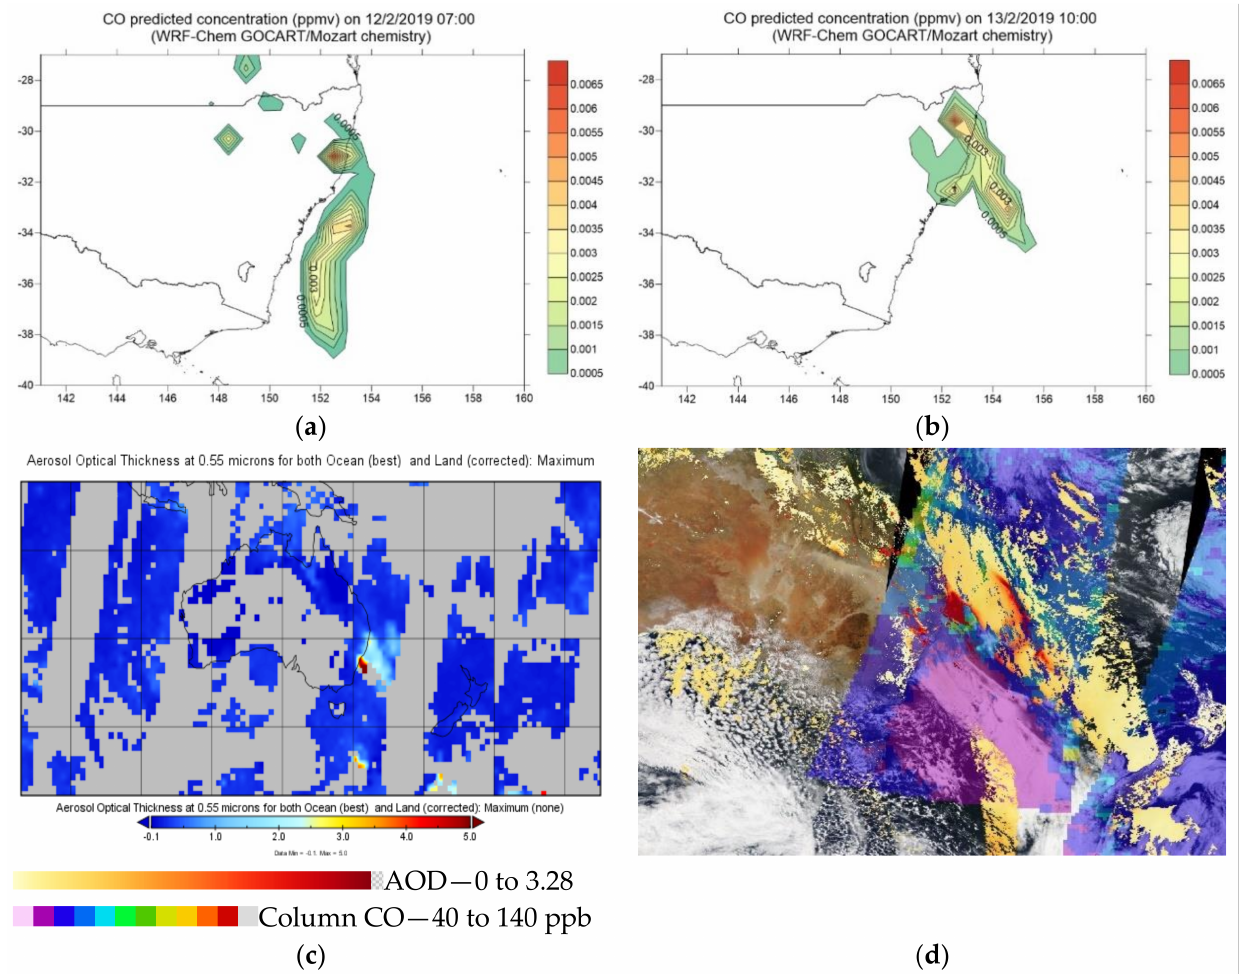
Figure 7. ( a ) WRF-Chem predicted Carbon Monoxide (CO) surface concentration (ppmv) at 12 February 2019 07:00 and ( b ) 13 February 2019 10:00 due to wildfires in New England area. ( c ) Maximum Aerosol Optical Depth (AOD) on 13 February 2019 3:50 UTC from MYD08-E3 (Aqua) satellite product and ( d ) combined AOD from ascending Aqua 3 km land and ocean on 13 February 2019 3:50UTC with daily night column CO from descending Aqua/Airs (greenish and bluish colours) on 13 February 2019 14:45